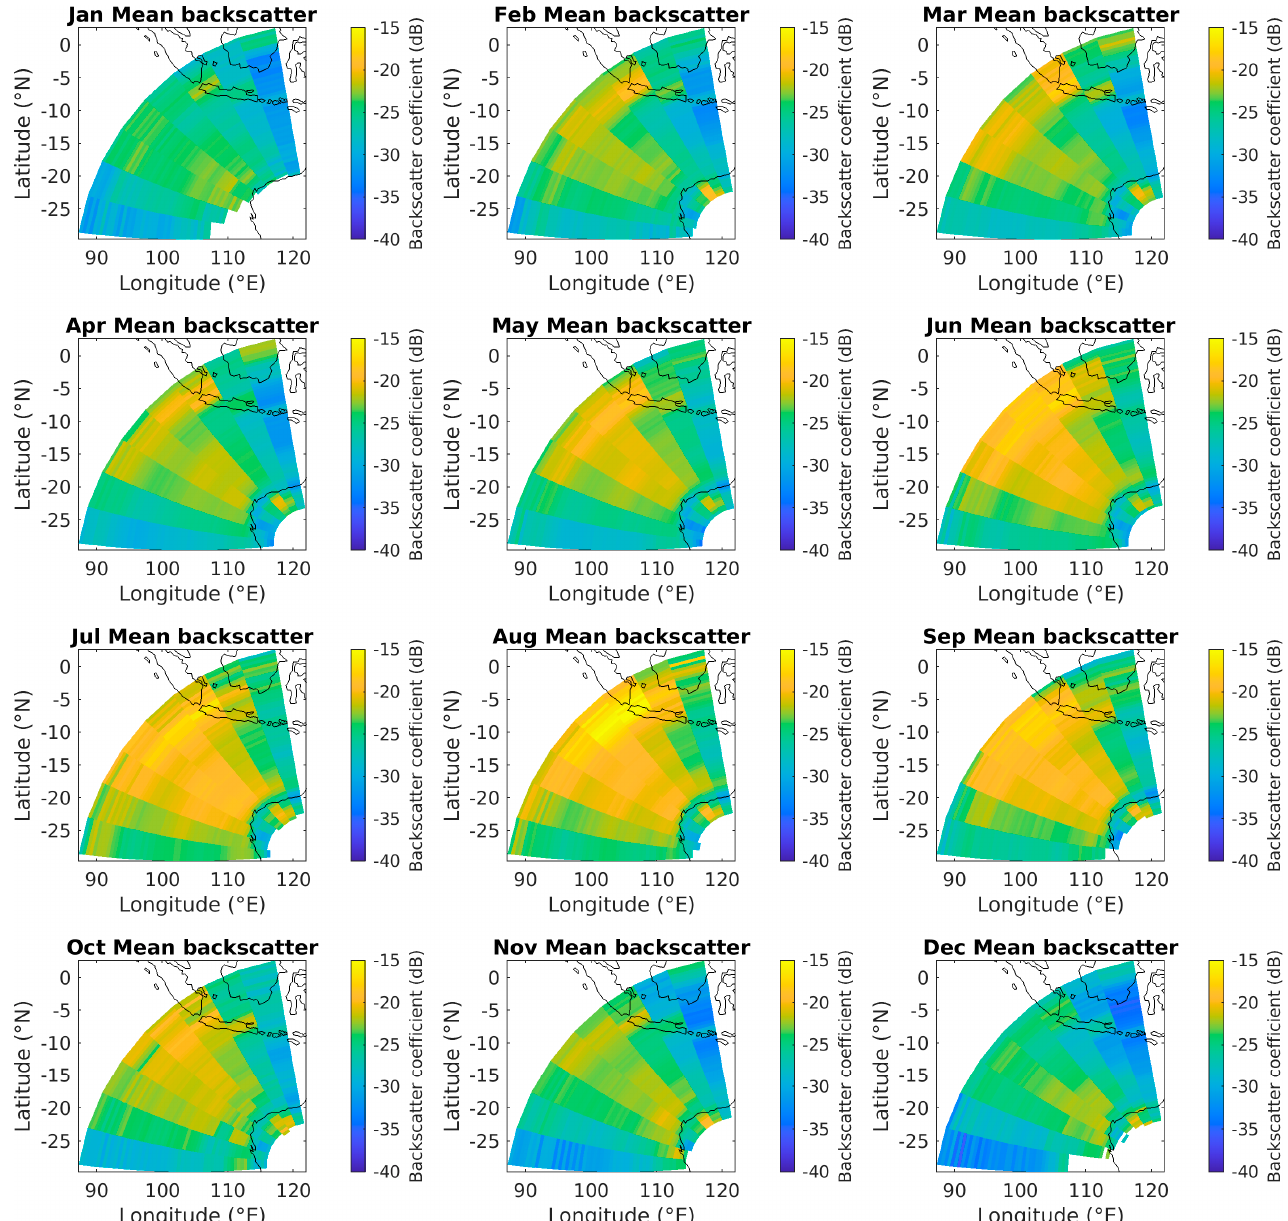
Figure 19. Decade mean of the monthly backscatter coefficients for LAW.